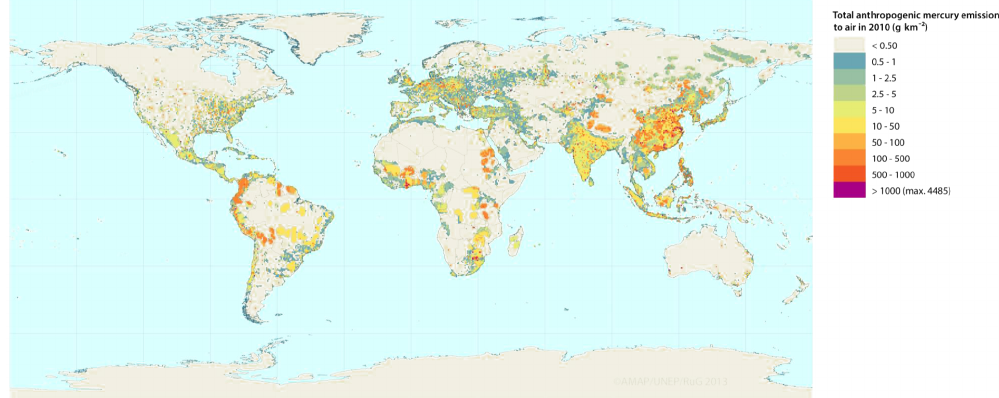
Figure 1. Spatial distribution of global anthropogenic emissions of mercury in 2010.